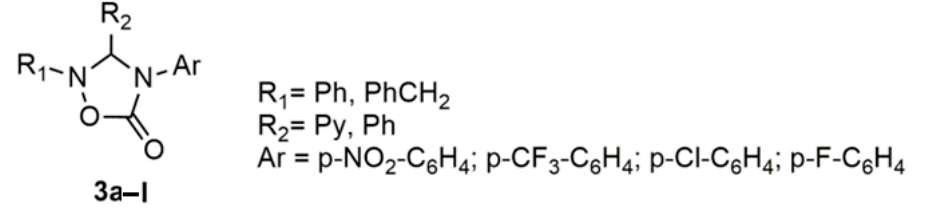
Figure 3. Cis -restricted azastilbenes.